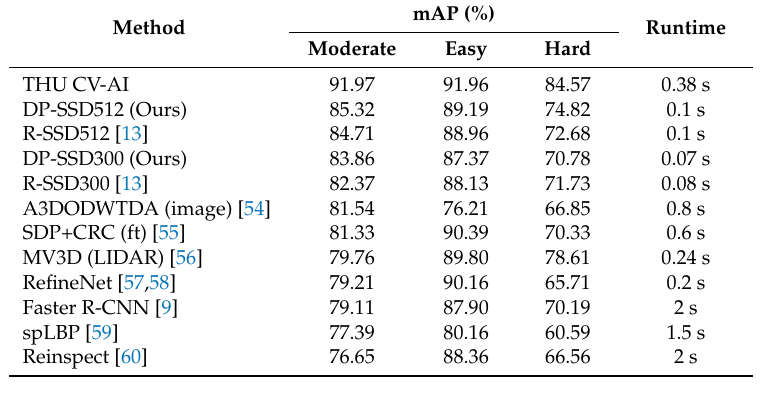
Table 7. Detection results between different methods on KITTI test set. All methods are ranked based on the “Moderate”.